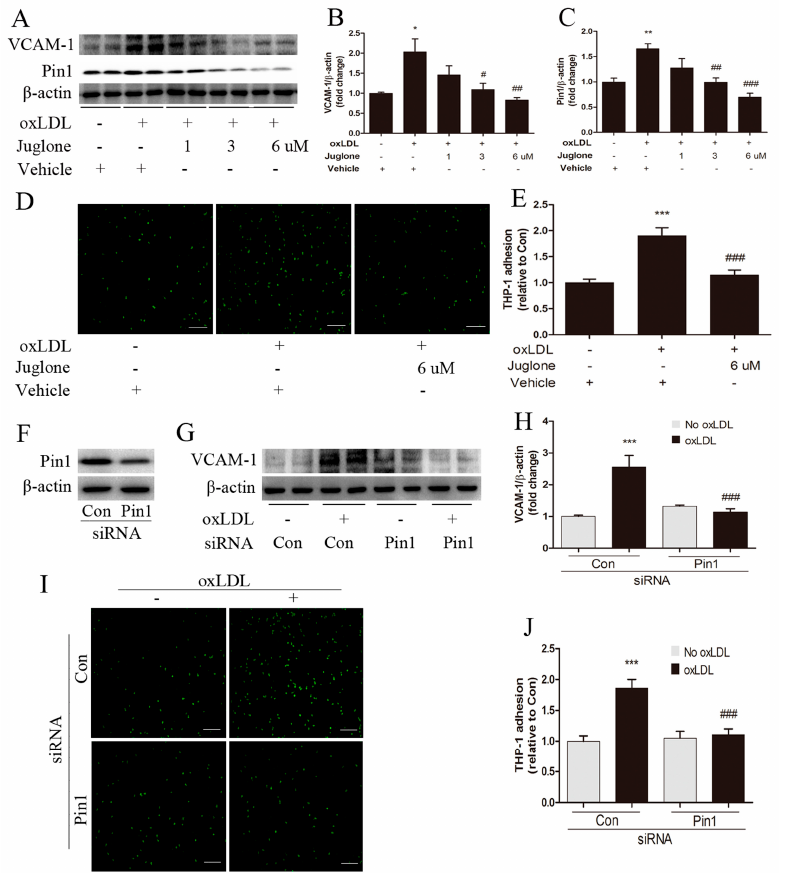
Figure 3. Pin1 impacts inflammatory response in oxLDL-induced EA.hy926 cells. Endothelial cells were pretreated with a vehicle or juglone (1, 3, 6 μ M) for 1 h prior to incubation with oxLDL (50 μ g/mL) for 24 h, as indicated. ( A – C ) Western blot was performed for the detection of VCAM-1 ( B ) and Pin1 ( C ) expression, normalized by levels of β -actin ( n = 4), and the representative bands are shown ( A ); ( D , E ) THP1 cells (in green) adhesion to EA.hy926 cells treated with juglone was measured as described in METHODS ( n = 6–8, Scale bar = 50 μ m); EA.hy926 cells were stimulated with oxLDL (50 μ g/mL) for 24 h after transfection with the control (Con) or Pin1 siRNA. Western blot was performed for the detection of Pin1 ( F ) and VCAM-1 ( G , H ) expression, normalized by levels of β -actin ( n = 4); ( I , J ) Adhesion of THP1 cells to EA.hy926 cells transfected with siRNA to knock down Pin1 ( n = 6, Scale bar = 50 µ m). * p < 0.05, ** p < 0.01, *** p < 0.001 vs. the vehicle group or the Con group; # p < 0.05, ## p < 0.01, ### p < 0.001 vs. the oxLDL-induced